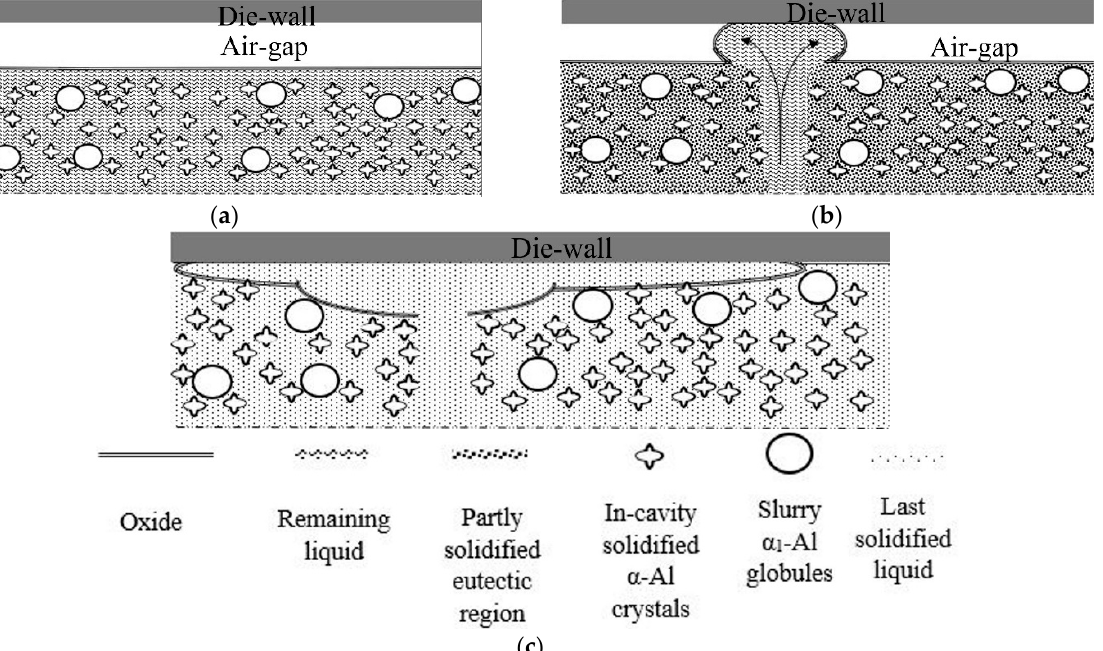
Figure 11. Illustration of the longitudinal section of the alloy surface layer during: ( a ) formation of an air gap between die wall and partially solidified alloy due to solidification shrinkage and thermal contraction. ( b ) The solute ‐ enriched liquid can flow through interdendritic channels or open, hot tears into the existing space between the solidifying layer and the die wall. ( c ) The solute ‐ enriched